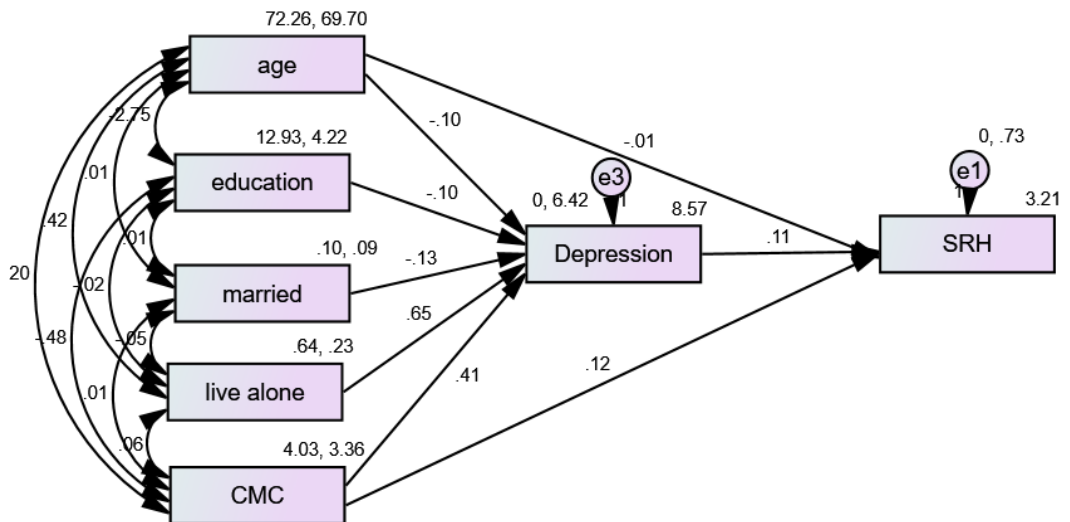
Figure 3. Summary of the Structural Equation Modeling (SEM) in African American (AA) women.